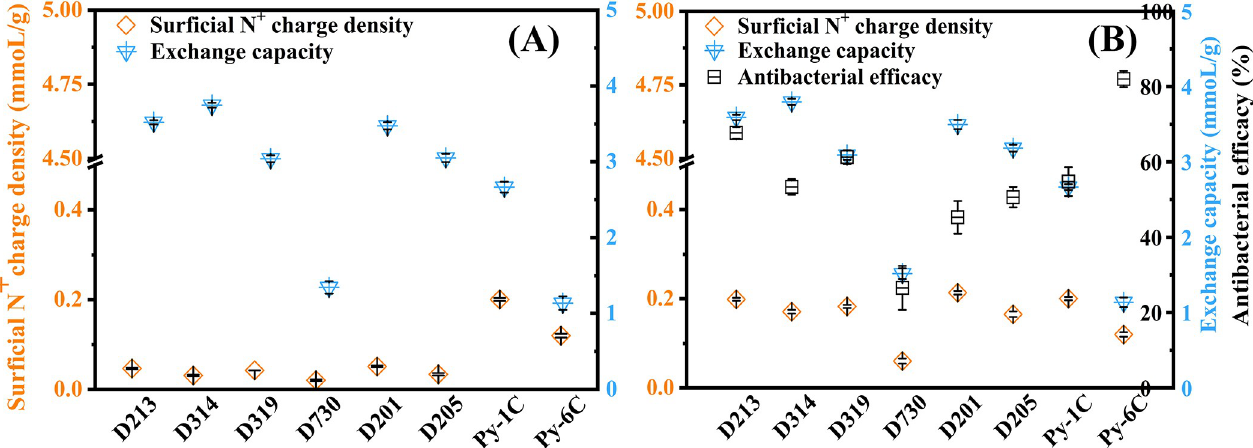
Fig 5. (A) Comparison of values of surficial N + charge densities and exchange capacities in different quaternary ammonium resins (QARs); (B) estimation application of surficial N + charge density indicating antibacterial efficacy in commercial QARs. Particle sizes of QARs are shown in S1 Table in S1 File (A); Particle sizes of QARs are of 80–100 mesh (B). All antibacterial experiments were performed at least in triplicate, and the error bars indicate the standard deviations from the mean values obtained.